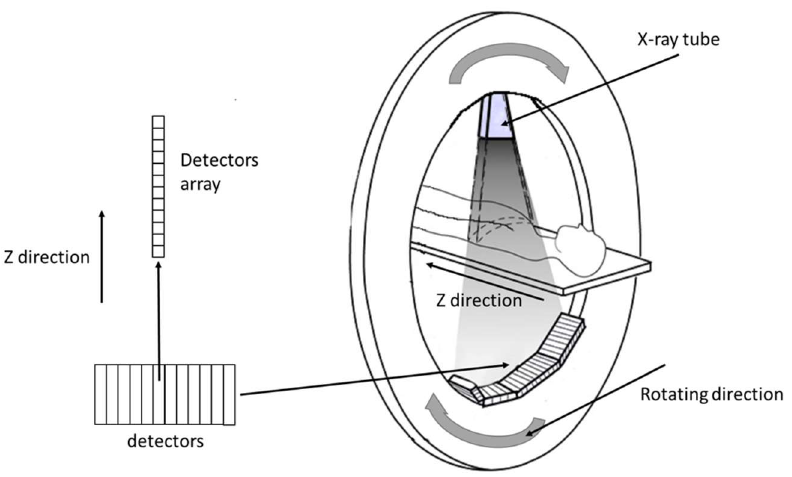
Figure 5. Detectors array design in a multi-slice computed tomography (MSCT) scanner.